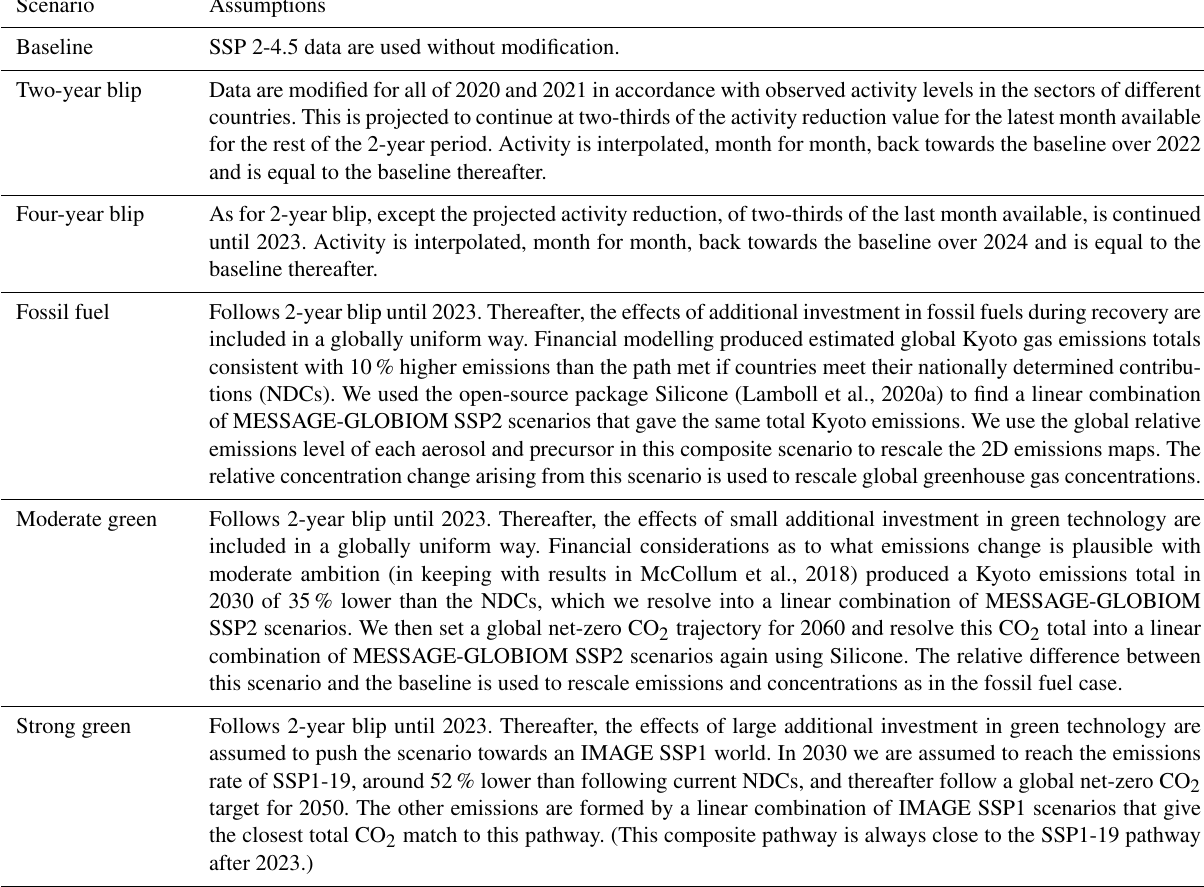
Table 2. Summary table for the differences between scenarios. For more details on how these were constructed, see Forster et al. (2020a). More details on the calculation of the emissions values themselves can be found in the file “InfillingCovidResponse.ipynb” in